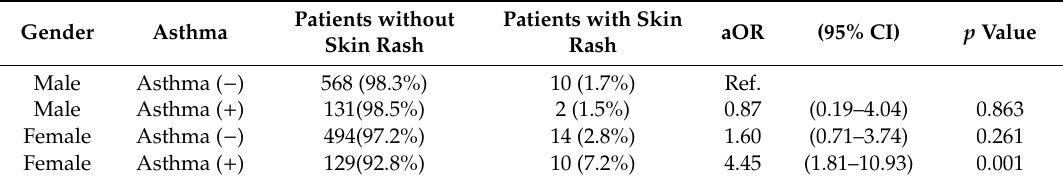
Table 2. A backward selection logistic regression model to estimate the adjusted odds ratios (aORs) of gender and